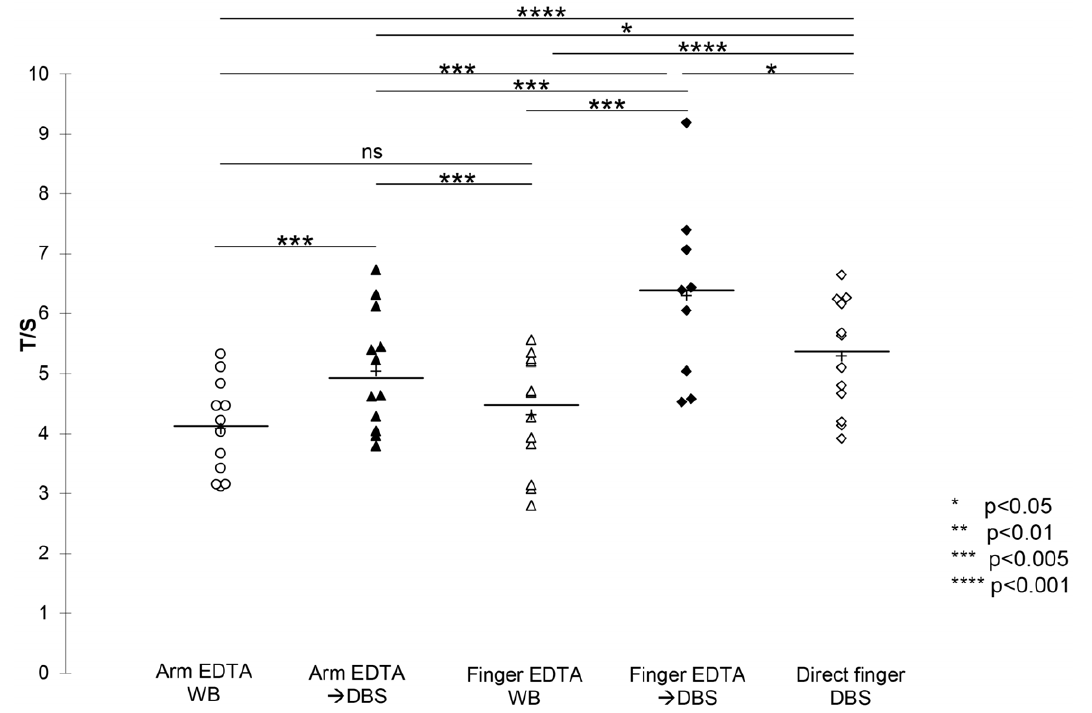
Figure 8. The effect of site of blood draw on T/S ratio measurements. T/S ratios were measured for DNA from arm EDTA whole blood, arm whole bloodDBS, finger EDTA WB, finger EDTADBS and direct finger prick blood made from a single blood draw from 12 distinct individuals. P values are shown, without adjustment for multiple comparisons. ns = not significant (p . 0.05). The line represents the median and the + represents mean.